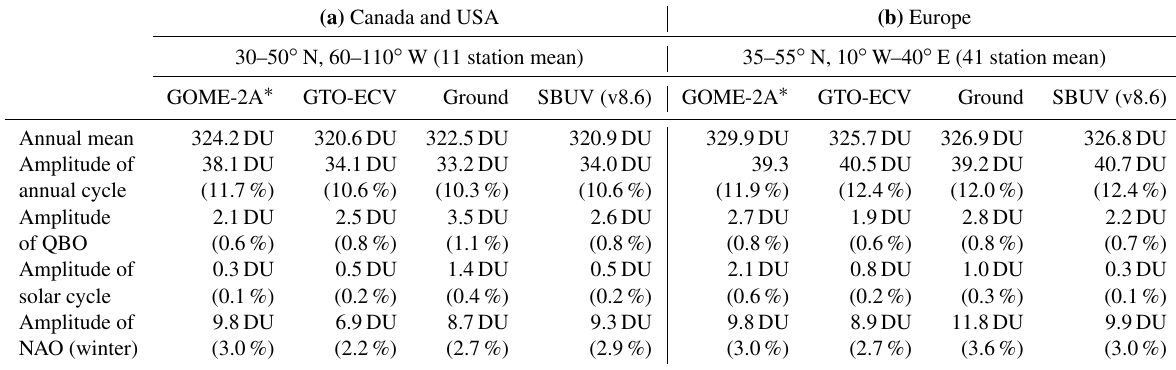
Table 7. Annual mean total ozone, amplitude of annual cycle, amplitude of QBO, amplitude of solar cycle, and amplitude of NAO in the period 1995–2016 from GOME-2A, GTO-ECV satellite data, ground-based observations, and SBUV (v8.6) satellite overpass data over (a) Canada and USA (11 station mean) and (b) Europe (41 station mean).